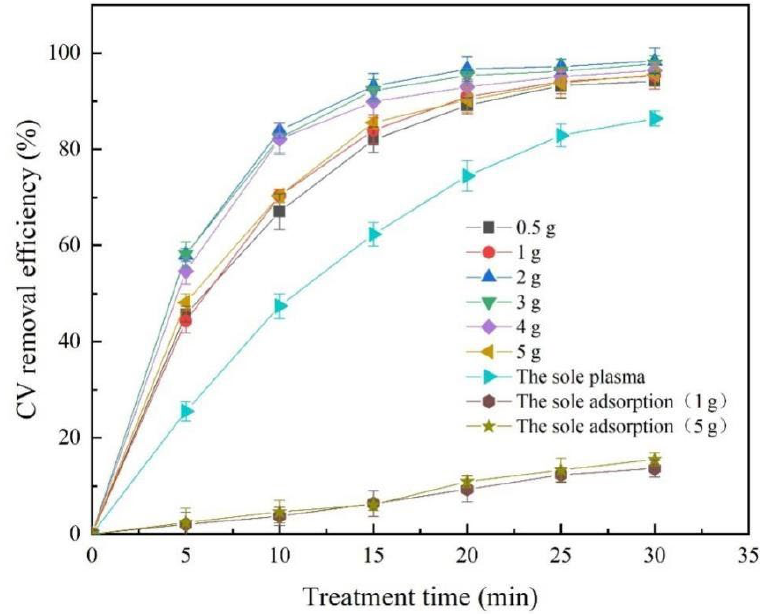
Figure 4. Effect of red mud dosage on CV removal. (Initial CV concentration = 25 mg/L, discharge voltage = 22 kV, frequency = 50 Hz, aeration O 2 = 3.0 L/min, conductivity = 26 μs/cm).